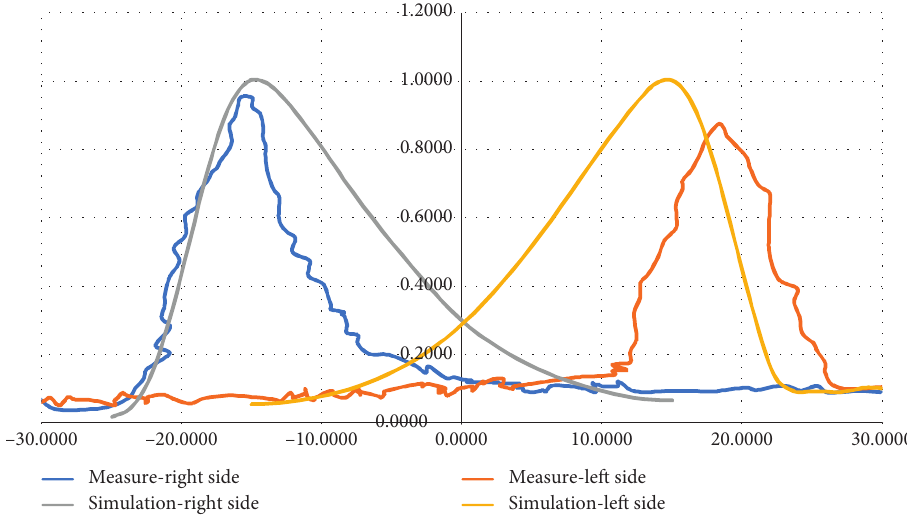
Figure 20: Distribution diagram of finished optical